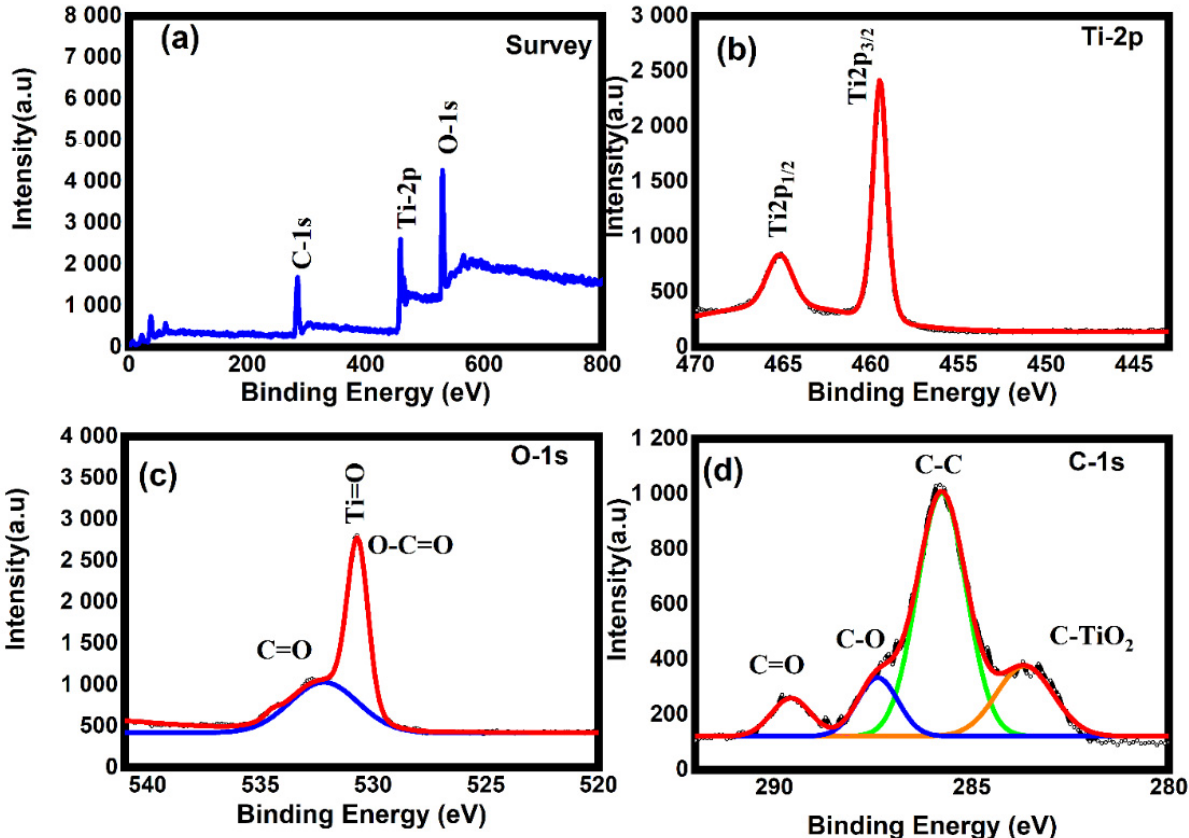
Figure 6. XPS images: wide ( a ), Ti-2 p ( b ), O-1s ( c ), and C-1s of AC/TiO 2